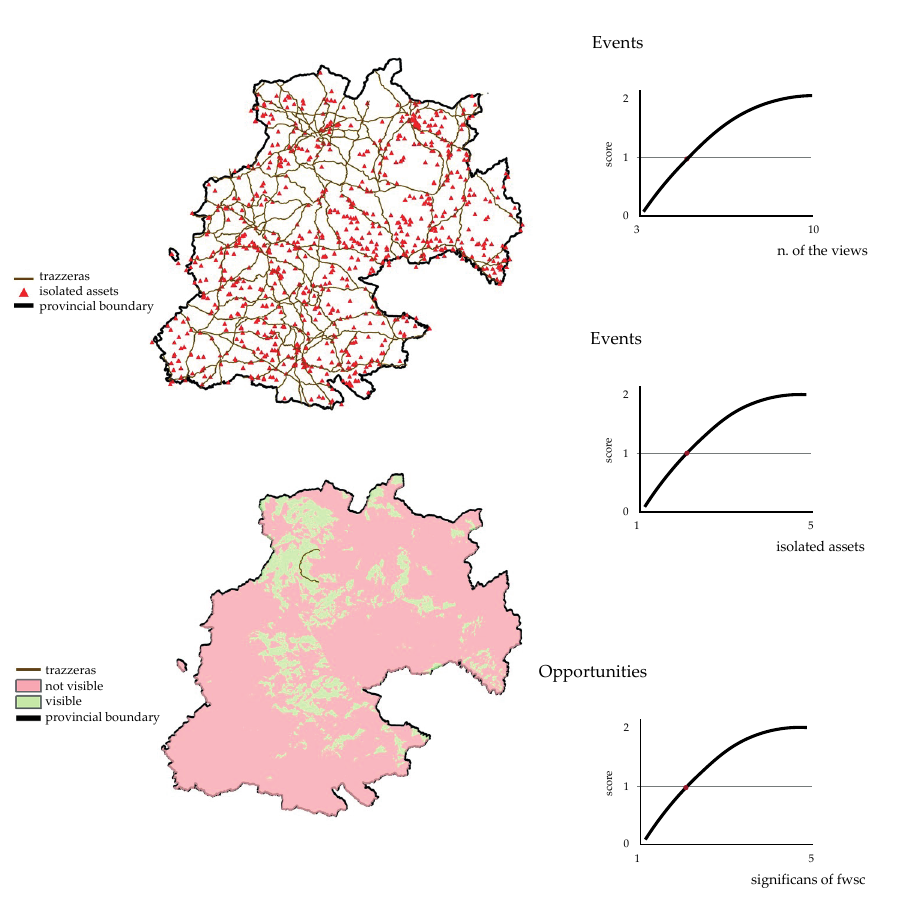
Figure 13. Playful values. Mapping and value functions.